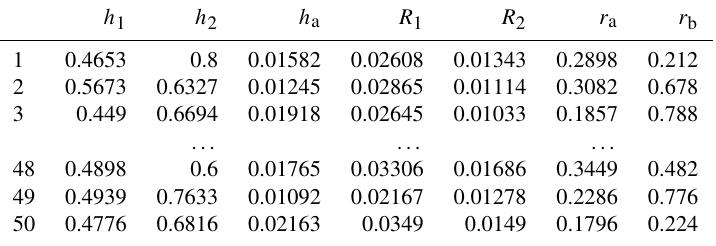
Table 2. Parameter variable design matrix in the experimental